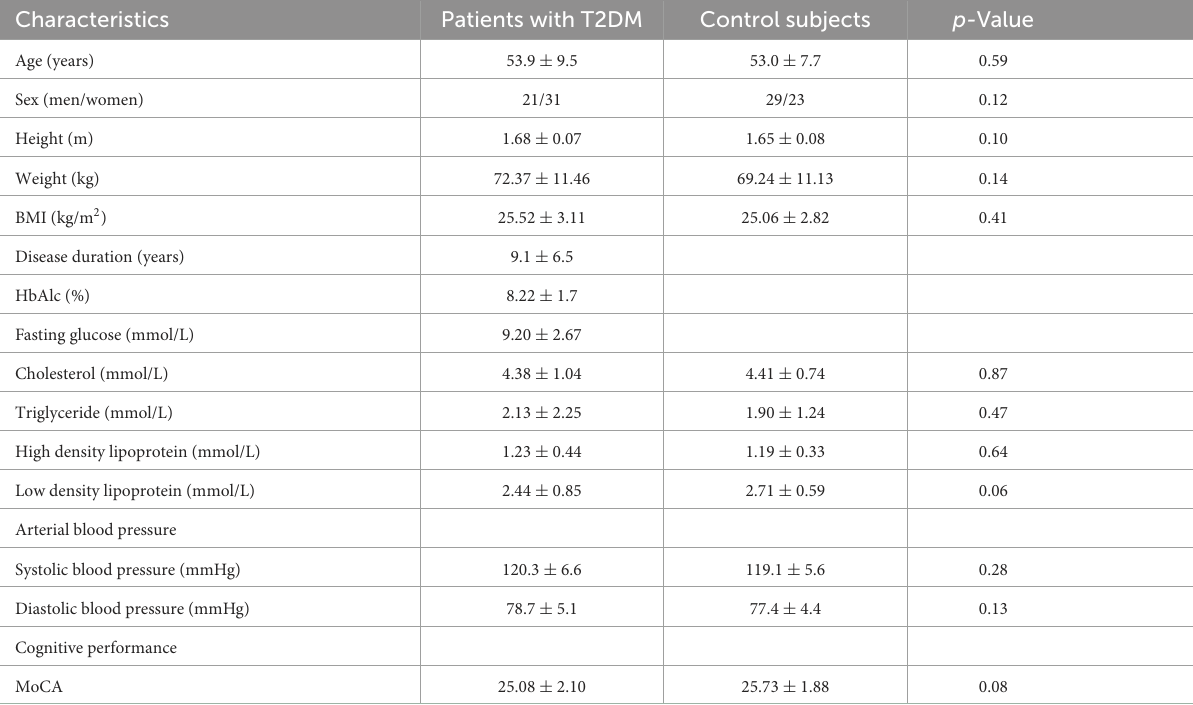
TABLE 1 Demographic and clinical characteristics of